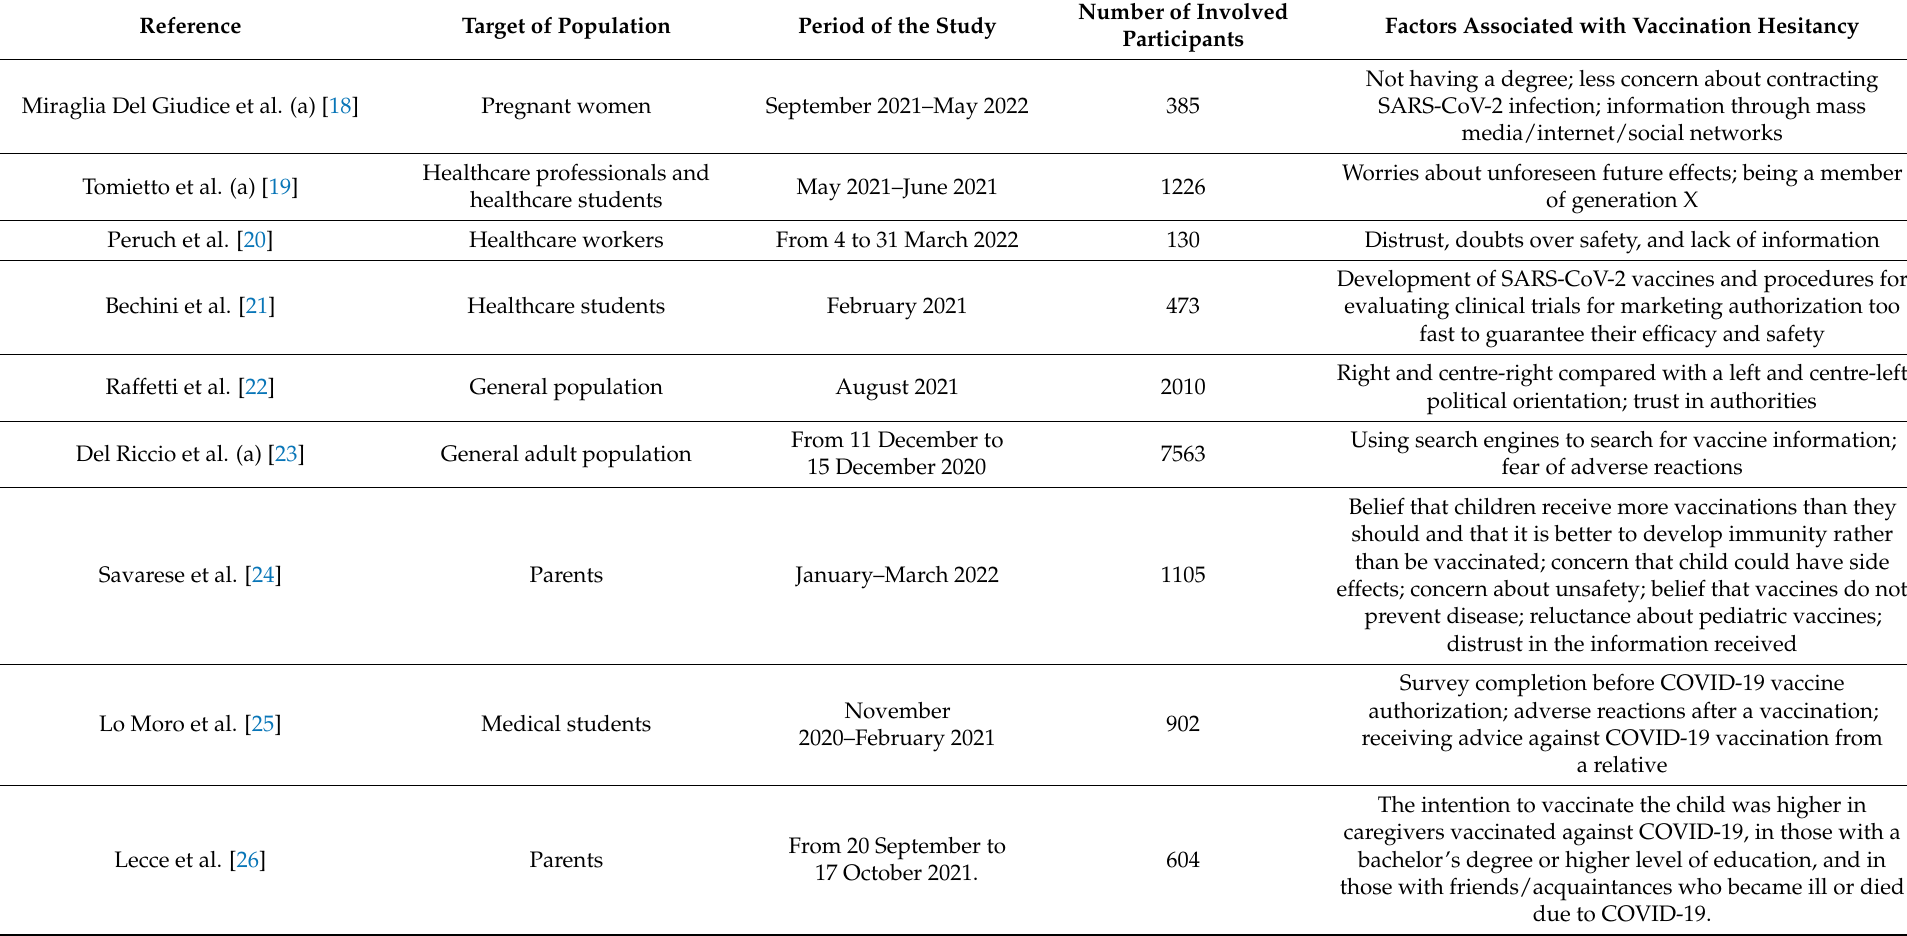
Table 1. Summary of the studies included in the present systematic